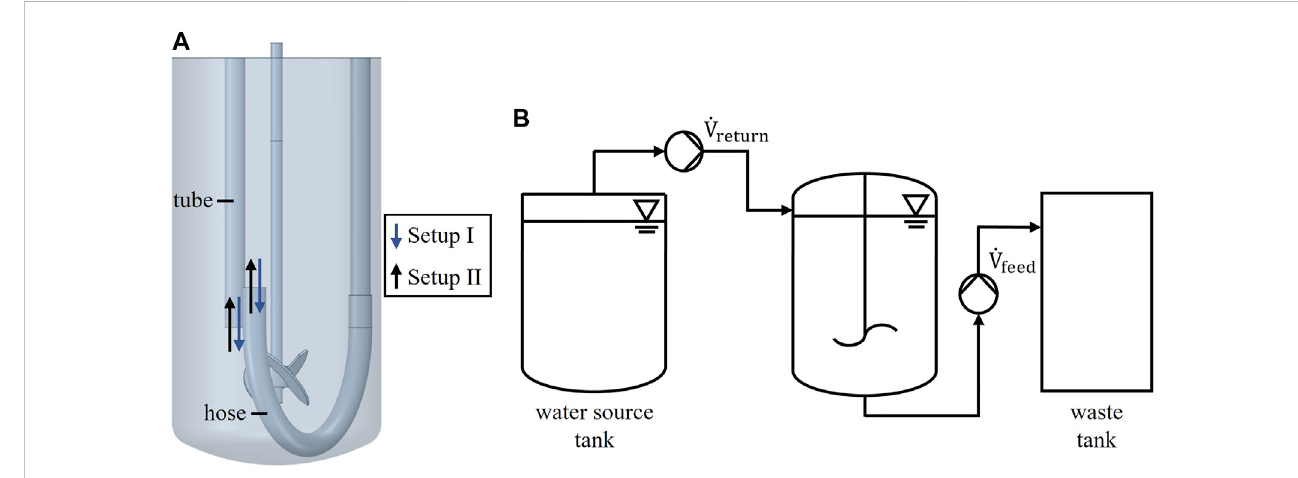
FIGURE 1 Reactor setup (A) , schematic representation of the experimental setup (B) .